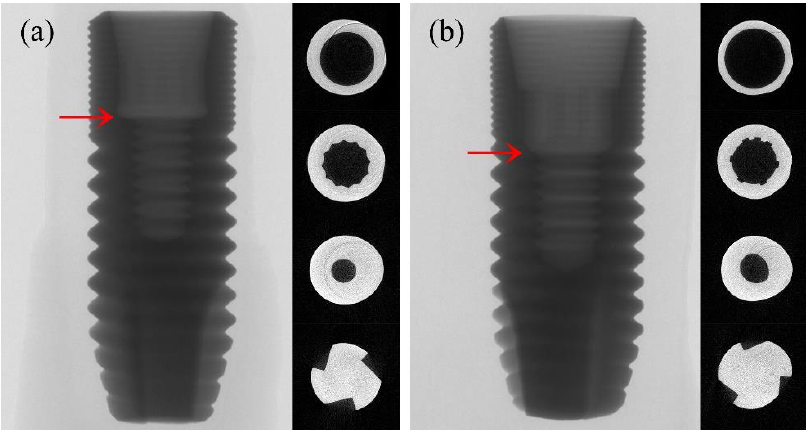
Figure 3. Frontal and cross-sectional micro-CT view: ( a ) TX, ( b ) EV; red arrow = location of the thinnest part of the implant fixture.